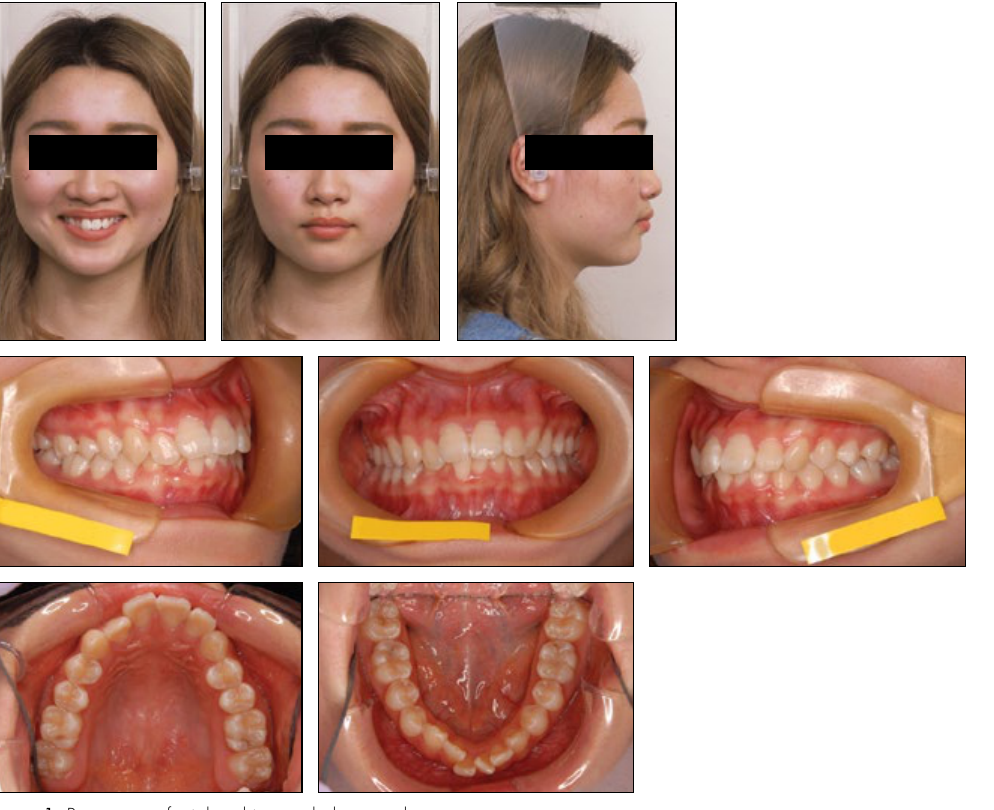
Figure 1. Pretreatment facial and intraoral photographs.